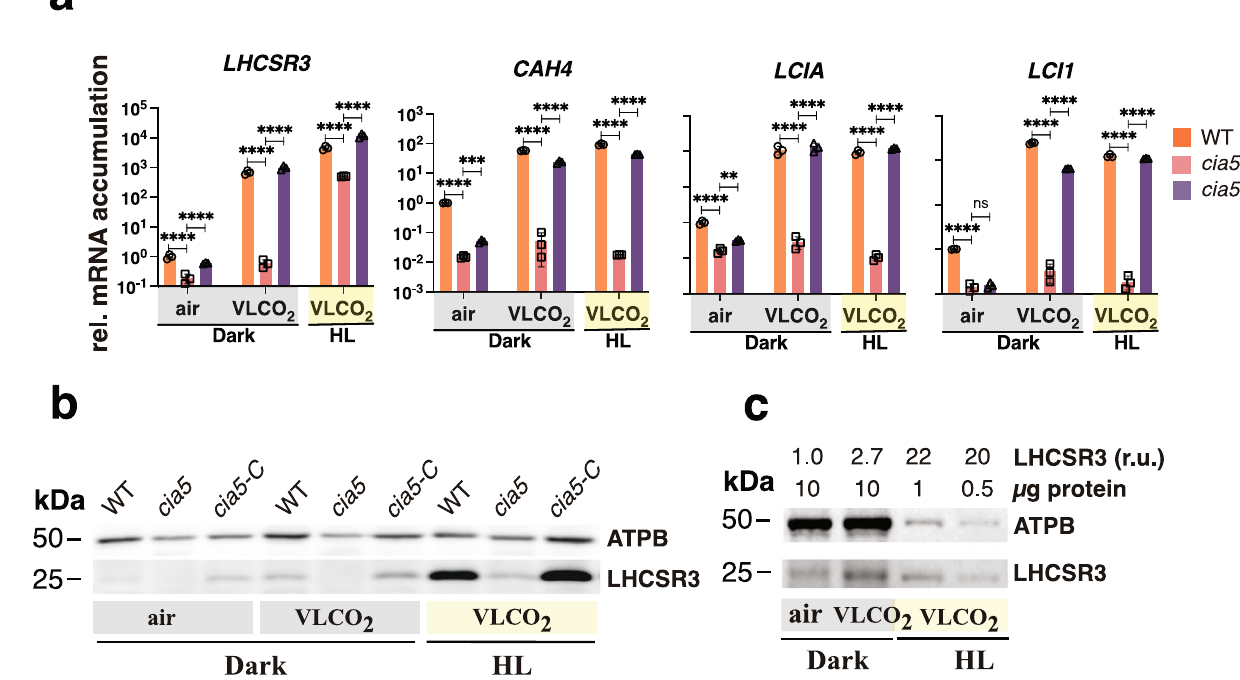
Fig.5|LowCO 2 levelscantriggerqEandCCMgenesintheabsenceoflight. WT, cia5 and cia5-C cells were bubbled with air overnight in darkness; next day air bubbling was either maintained or replaced by CO 2 -limited-air bubbling in the darkness or in the presence of 600 µ mol photons m − 2 s − 1 light. Sampling was per- formed after 1h (RNA) or 4h (protein). a mRNA accumulation of LHCSR3.1 (qE gene) and CAH4, LCIA, LCI1 (CCM genes) in WT, cia5 and cia5-C . Data were nor- malized to WT air dark;( n =3 biological samples, mean± s.d.).Thep-values forthe comparisons of WT with cia5 and cia5 with cia5-C are based on ANOVA Dunnett ’ s multiple comparisons test of log10 transformed mRNA data as indicated in the